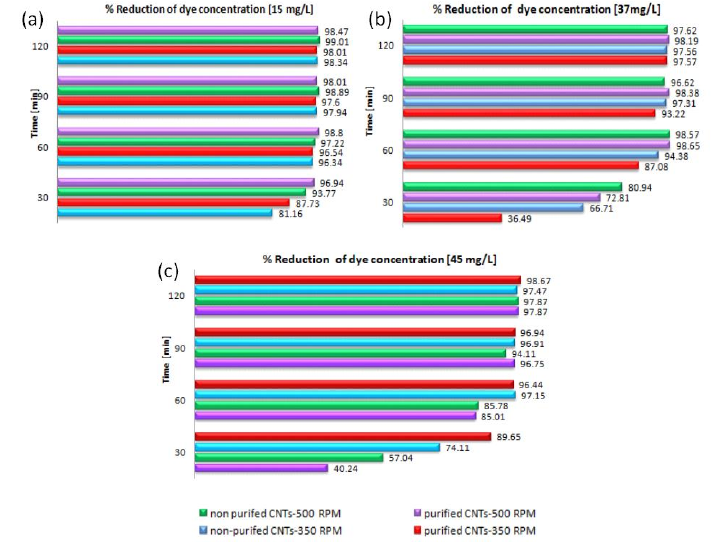
Figure 7. Percentage of abatement in dye solutions, depending on the type of nanotubes and the stirring speed, with initial concentrations: ( a ) 15 mg/L; ( b ) 37 mg/L; ( c ) 45 mg/L.